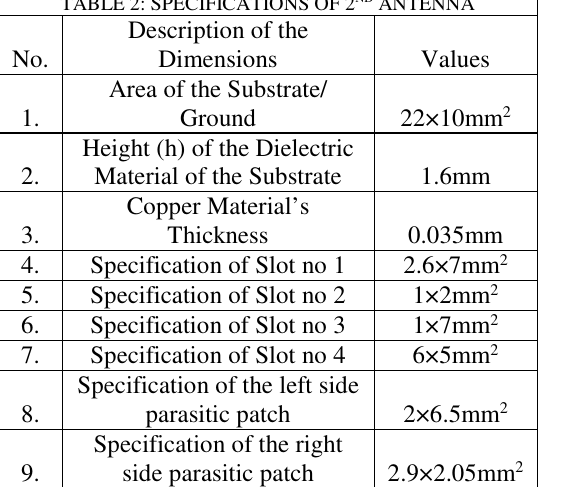
TABLE 2: SPECIFICATIONS OF 2 ND